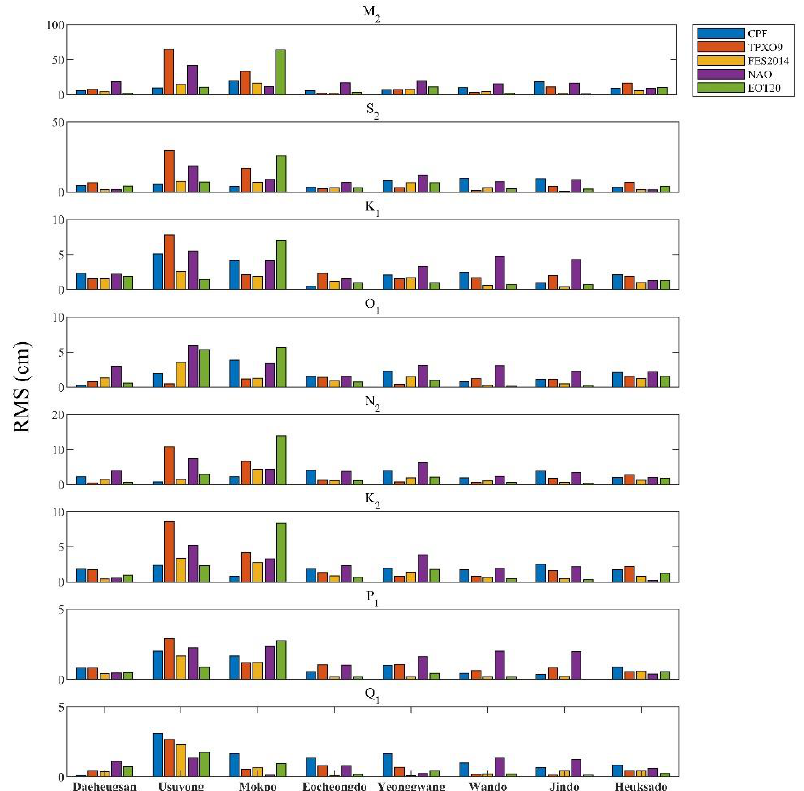
Figure 3. The RMSEs (unit: cm) of the harmonic constants calculated by the CPF method, and those of the TPXO9, FES2014, NAO.99b and EOT20 models for eight major constituents, compared with observations of each tidal gauge. The locations of the eight gauges are shown in Figure 1.